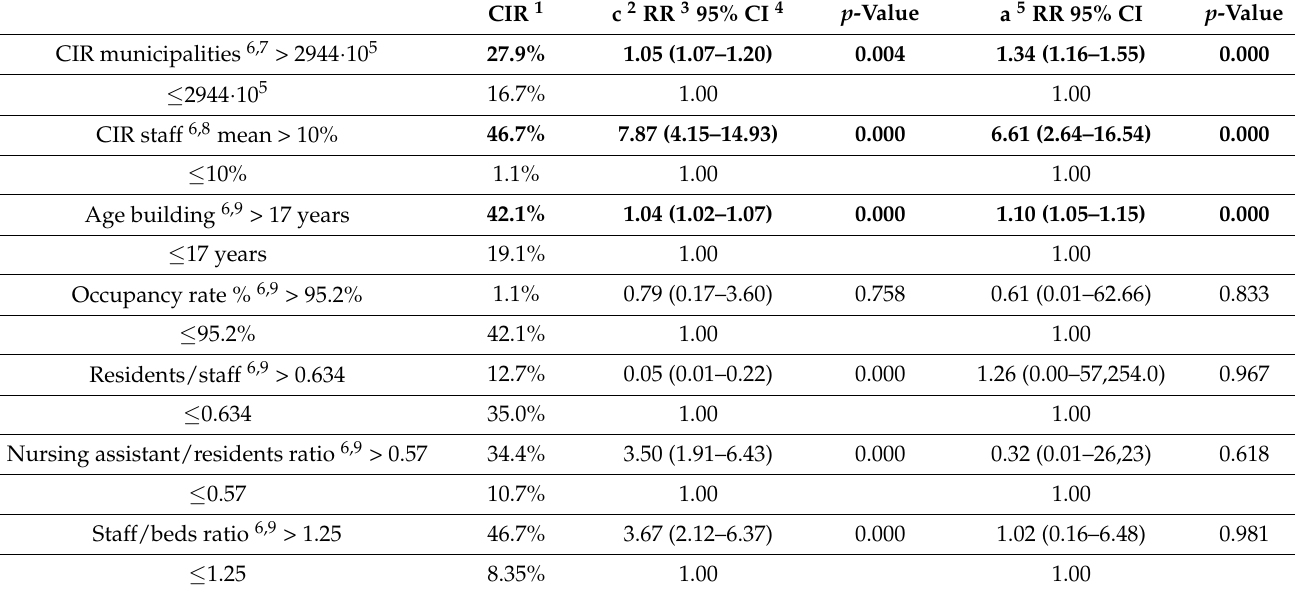
Table 4. Risk factor of COVID-19 incidence in long-term care residential homes (LTCRH) for